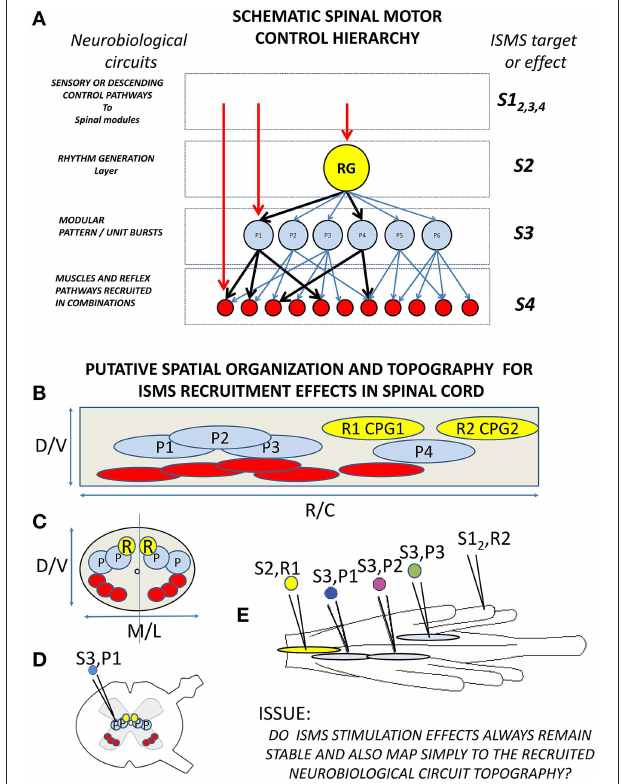
FIGURE 5 | Schematic of neurobiological hierarchies and modularity in spinal cord, and topographic organization and ISMS. (A) The current understanding of the spinal motor hierarchy in modular terms . On the left are the neurobiological component labels. A rhythm generator and pattern shaper layer form the CPG. In, or just below the pattern shaping layer are the modular motor primitives which recruit specific motor pools in specific balances (e.g., heavy black lines). On the right are levels of ISMS stimulation targeting into this hierarchy: S1 stimulation of afferent or descending controls into the hierarchy (e.g., reticulospinal drive, or afferent feedback to synergists); S2 stimulation of rhythm generation; S3 stimulation of motor primitives; S4 stimulation of motor pools. (B,C) Schematic topography of circuitry and best targets of ISMS in spinal cord (These need not be identical). (B) Lateral or sagittal view of cord gray matter (cell bodies and dendrites). (C) Cross section of cord gray. CPG rhythm centers (yellow), synergies/primitives (blue) and motor pools (red) are organized both along the cord and at different depths and mediolateral locations. (D) Gray matter and targets in white matter in a more realistic cross section. (E) Top view of a frog cord with different targets and the relations of importance for ISMS interactions. S2,R1: stimulation of CPG rhythm generation R1 in gray matter. S3,P1 and S3, P2: stimulation of primitives in gray matter on same side of cord (expected vector superposition). We do not know if S3,P1 and S3,P2 stimulation operate similarly when S2, R1 is activated in parallel. S3,P3: stimulation of a contralateral primitive in spinal cord. This might alter superposition of S3,P1 and S3,P2 and may not show vector superposition with S3,P1 alone. S1,R2 stimulation of afferent driving